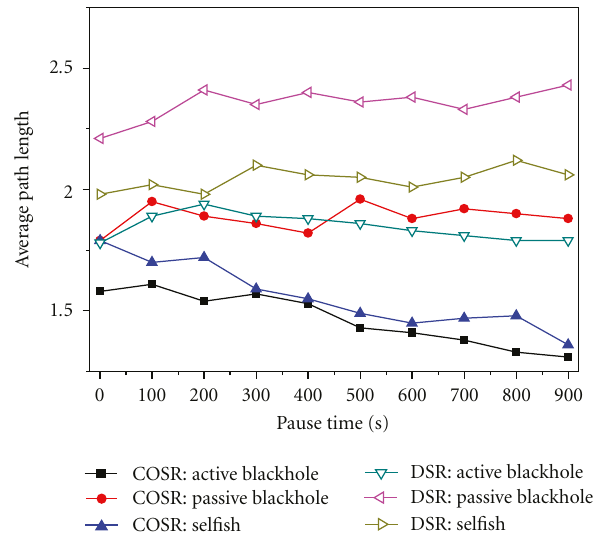
Figure 10: APL of COSR and DSR with various pause time.